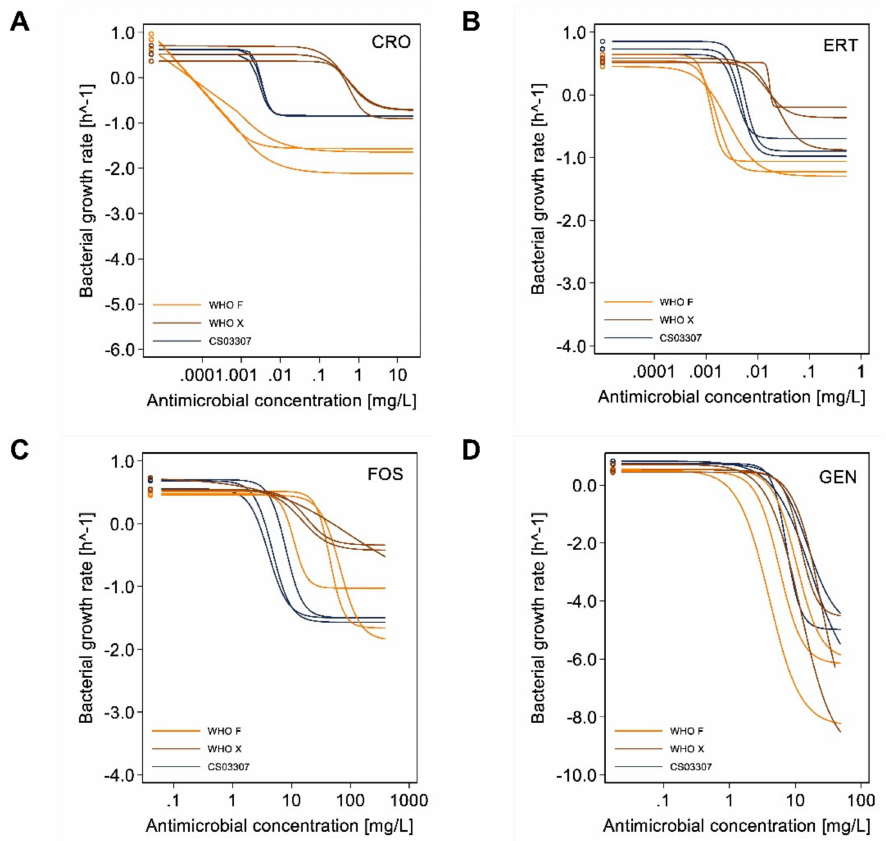
Figure 5. Curves representing the pharmacodynamic functions of specific antimicrobials (i.e., cef- triaxone ( A ), ertapenem ( B ), fosfomycin ( C ) and gentamicin ( D )) for the three different strains of Neisseria gonorrhoeae . Curves for the WHO F strain (ceftriaxone susceptible, high fosfomycin MIC) are presented in yellow lines, WHO X (ceftriaxone resistant, high fosfomycin MIC) in brown lines and CS03307 (ceftriaxone susceptible, low fosfomycin MIC) in navy blue lines. Curves from the three independent experiments with each combination of antibiotic and strain are presented.